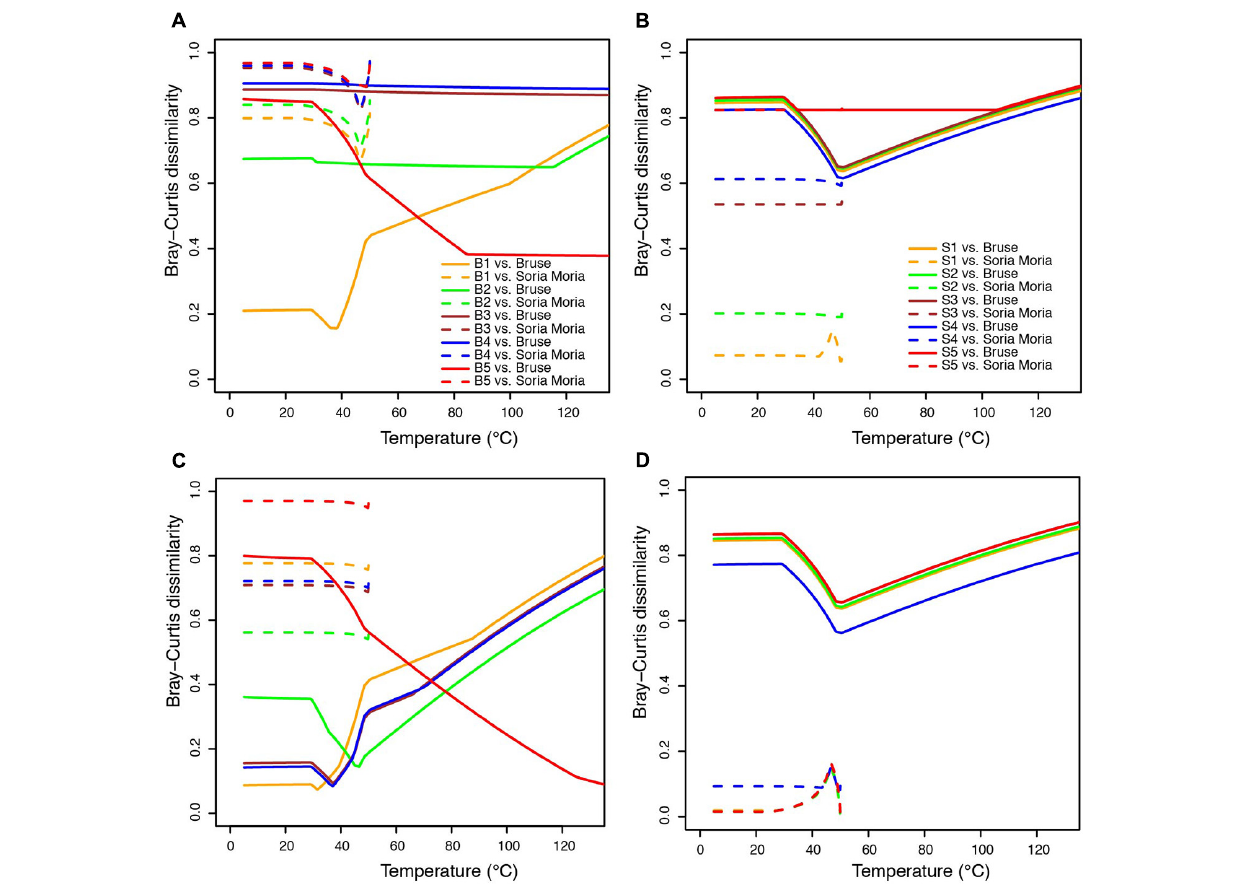
FIGURE 6 | Bray-Curtis Distances (BCDs) between modeled communities and relative abundances among functional groups of primary producers in environmental samples—i.e., only considering organisms assigned to the functional groups defined in Table 2 . Functional assignments of detected taxa are shown in Figure 5 . Each line shows BCD values in comparisons between one sample and all modeled communities in one chimney. Low BCD values indicate good fits between models and sampled communities. (A) BCDs between sampled communities in the Bruse chimney and modeled communities from the Bruse chimney and the Soria Moria chimney. (B) BCDs between sampled communities in the Soria Moria chimney and modeled communities in the Bruse chimney and the Soria Moria chimney. (C,D) same as (A,B) , respectively, except that methanogens and sulfate reducers are not considered as primary producers and that Marine Gr. 1 are considered